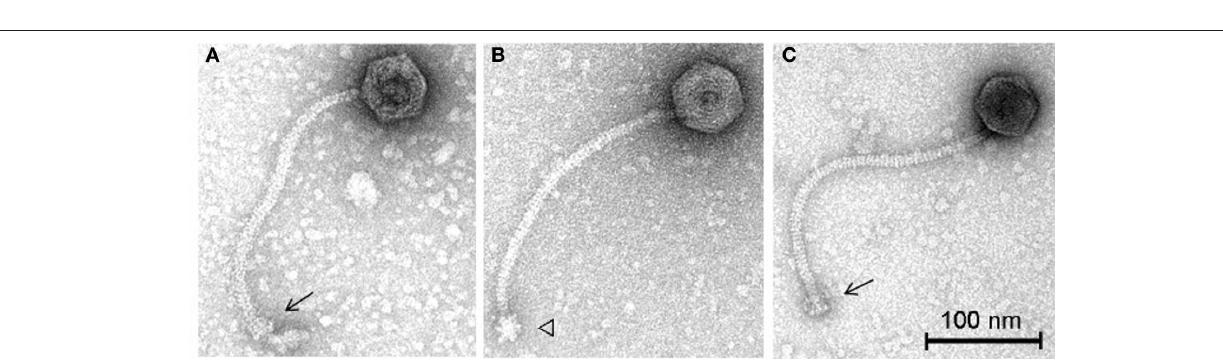
FIGURE 6 | Transmission electron micrographs of phages vB_LmoS_188 (A) and vB_LmoS_293 (B,C) negatively stained using 2% uranyl acetate. The double-discs conformation of the baseplates is indicated by the arrows (A,C) . The six-pointed star conformation of the phage vB_LmoS_293 baseplate is indicated by the triangle in (B)